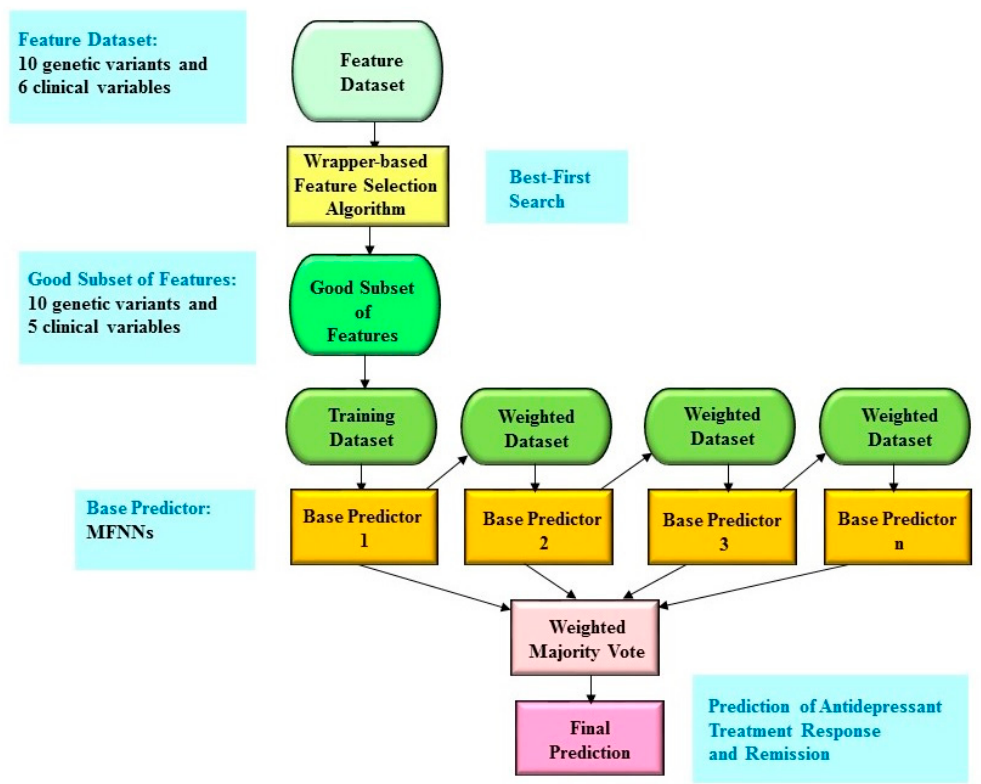
Figure 1. The schematic illustration of the boosting ensemble predictive framework with feature selection. First, the wrapper-based feature selection algorithm is performed to select a good subset of features, which provides the input to the boosting ensemble predictive algorithm. Next, the idea of the boosting ensemble predictive algorithm is to train base predictors in a sequential process such that each base predictor manages to adjust its predecessor. A higher weight is then designated to samples that are wrongly predicted by earlier rounds. In other words, base predictors are performed sequentially by using a weighted version of the dataset within the training phase. Finally, the prediction is generated by a weighted majority vote. In this study, we chose multi-layer feedforward neural networks (MFNNs) as the base predictor.